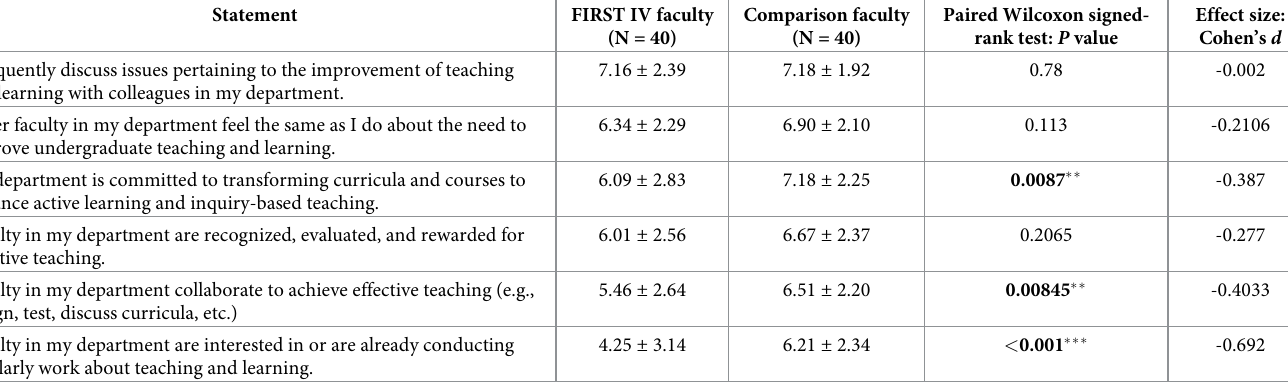
Table 2. The degree to which faculty agree or disagree with statements about departmental culture around teaching (0 = Strongly disagree, 10 = Strongly agree). Reported values for faculty are the mean and standard deviation within a group. Statements are ordered by agreement as self-reported by FIRST IV faculty (Strongly agree to strongly disagree). Data originate from the background survey (S1